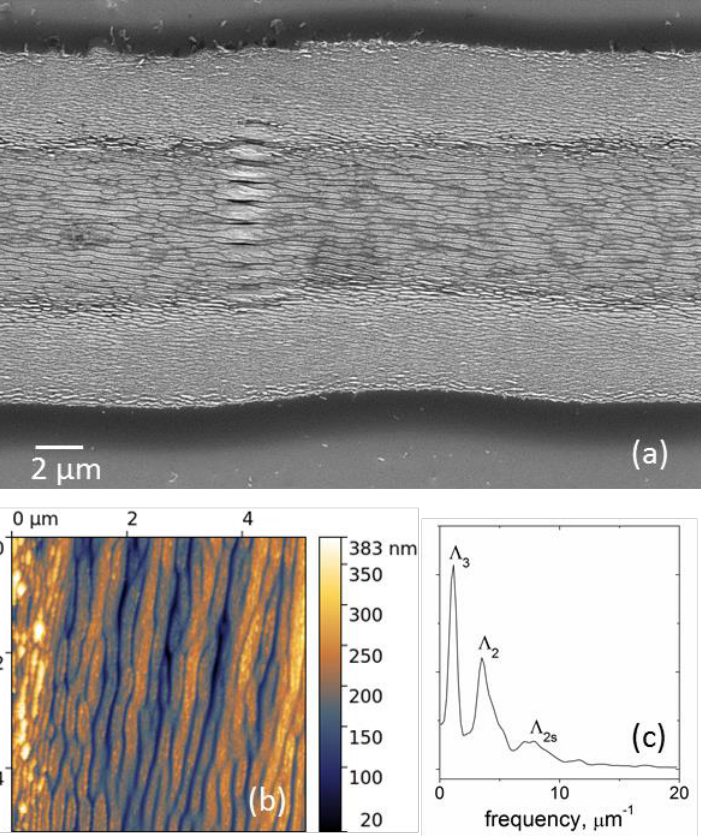
Figure 8. ( a ) SEM image of the microgroove on the DLN film produced at F = 0.25 J/cm 2 and scanning velocity v s = 0.04 m/s, and ( b , c ) AFM image of the groove bottom with a corresponding 1D-FFT spectrum in the direction perpendicular to the ripples.